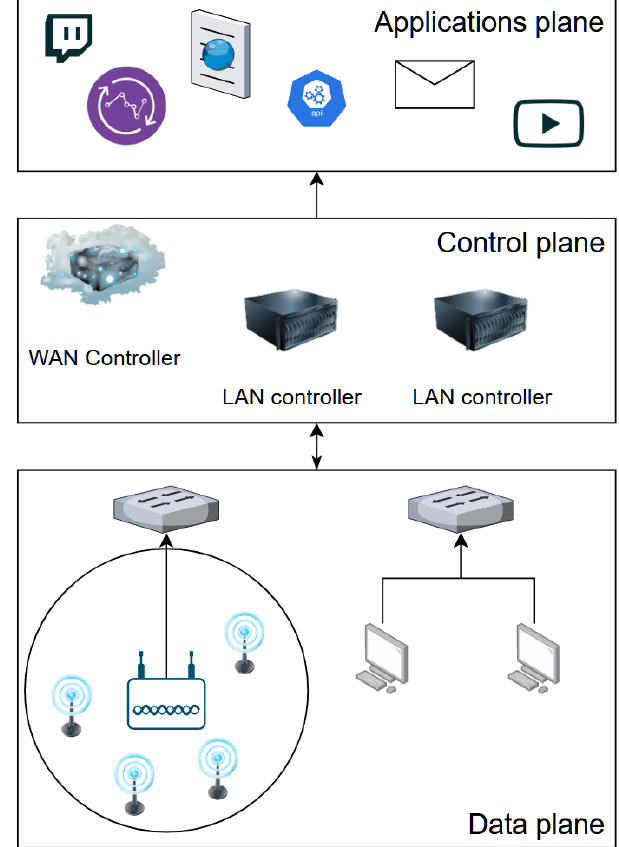
Figure 1. SDN architecture.